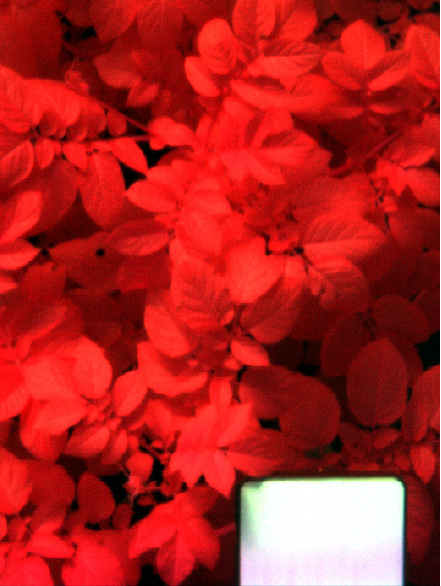
Figure 1. Hyperspectral image taken at 3 m above the canopy. False-color image showing red as band 90, green as band 60, and blue as band 40.